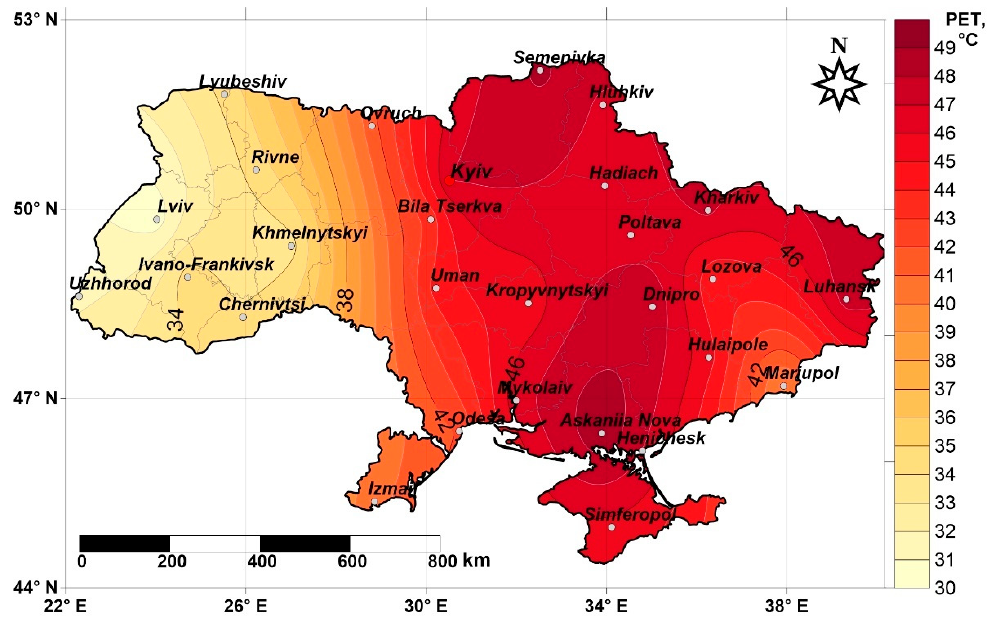
Figure 5. PET values (°C) at 12 UTC on 8 August 2010. The daily variation of PET values in the period from 31 July to 17 August 2010 for selected stations (Kharkiv, Luhansk, Hlukhiv, Kropyvnytskyi, Kyiv and Simferopol) was similar to the variation of daily air temperature values (Figure 6), with minimum values occurring before sunrise or in the early morning (3 or 6 EEST (UTC+3)) and maximum values occurring at noon or after midday (12 or 15 EEST). PET values at 6 EEST were found to be greater than those at 3 EEST in 28.7% of cases. PET values at 12 EEST were greater than those at 15 EEST in just 18.5% cases. The range of PET values recorded simultaneously (at any given time) across the observation network was generally small (just a few degrees Celsius) on only a few days, and less than 10.0 ◦ C in the vast majority of cases. The largest range of PET value range of 19.0 ◦ C was recorded across the network at 9 EEST on 13 August 2010. The next largest range recorded across the observation network included 16.5 ◦ C on 12 August, 16.0 ◦ C on 16 August, 15.9 ◦ C on 2 August), and 15.0 ◦ C at 12 EEST on 9 August).